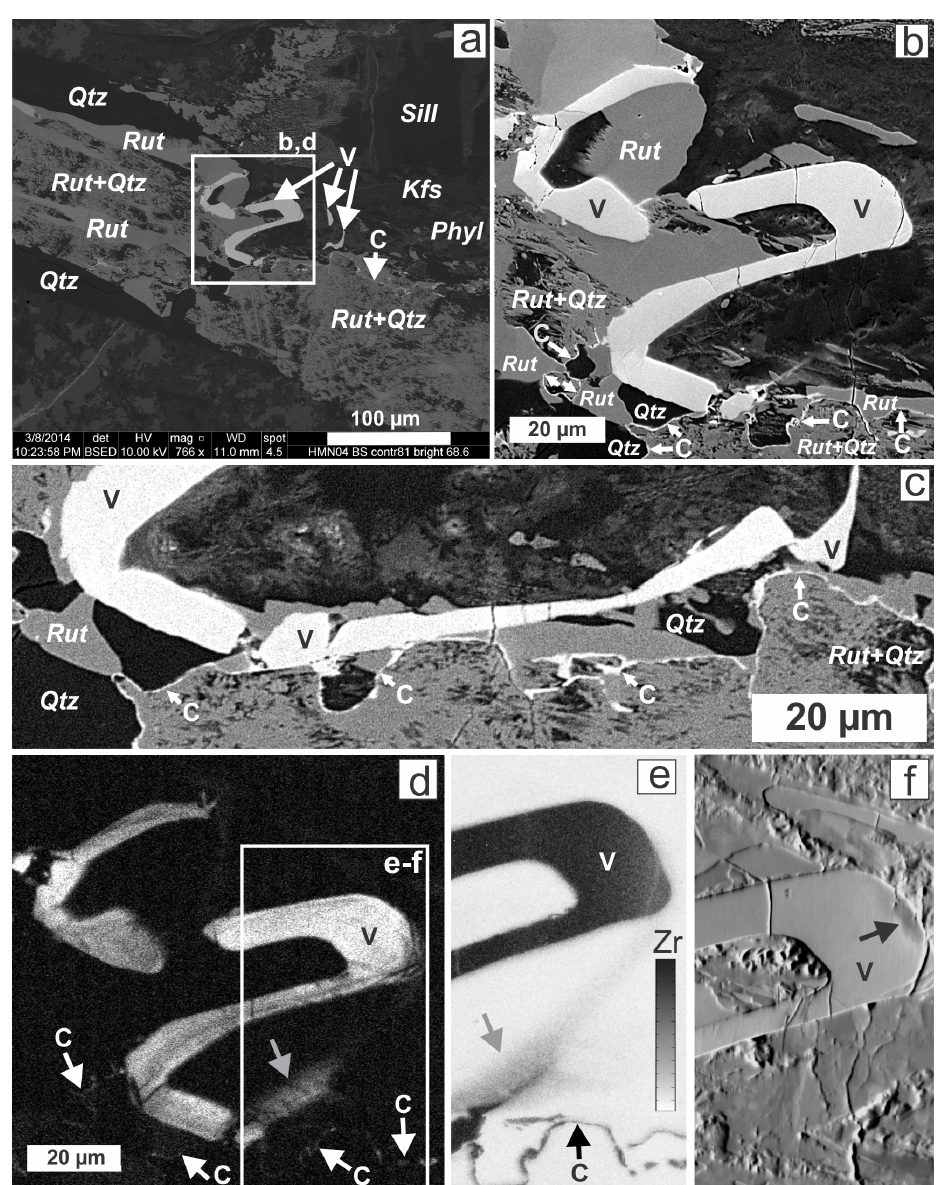
Figure 4. (a) BSE image of the zircon aggregate, which forms intergrowth with rutile and quartz. White rectangle highlights the area enlarged in panels (b) and (d) . (b) Enlarged BSE image of the area indicated in panel (a) . Arrows point out the direction of reaction fronts. (c) Enlarged area of the lower part of panel (b) . The middle part of vermicular texture (“V”) is present (it was subsequently polished away and thus absent in panels (a–b) . Arrows point out the direction of the reaction front. (d) Enlarged CL image of the area indicated in panel (a) . White arrows as in panel (b) ; grey arrow points to the wedged zircon texture that continues below the surface. (e) Qualitative EDX intensity map for Zr of the area indicated in panel (d) . Black arrows point out the direction of reaction front; grey arrow as in panel (d) . (f) Orientation contrast image of the area indicated in panel (d) . Arrow points to plastically deformed tip of vermicular zircon grain. V in panels (a–f) highlights vermicular zircon grains and C highlights zircon coronae. Mineral abbreviations as in Fig. 1; Kfs: K-feldspar.